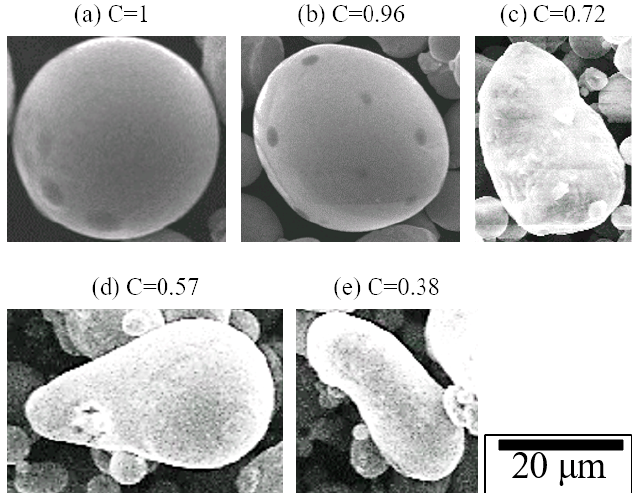
Figure 4. Examples of particle circularity for the metal powders used in this study. Representative images of ( a , b ) are taken from 316L SS, while those of ( c – e ) are taken from AlSi10Mg.